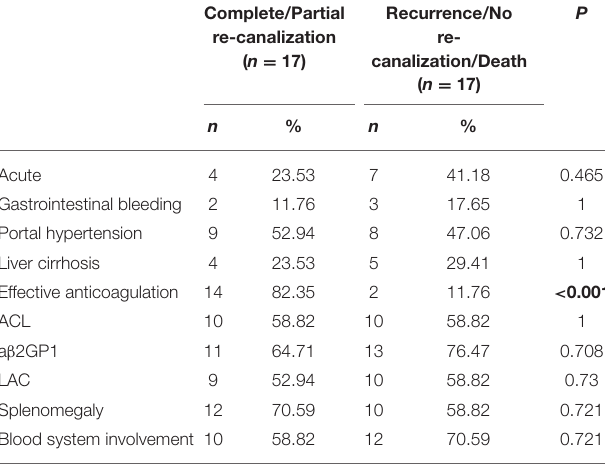
Values in bold are statistically significant at p < 0.05. LAC, lupus anticoagulant; ACL, anticardiolipin; anti β 2GPI, anti- β 2-glycoprotein